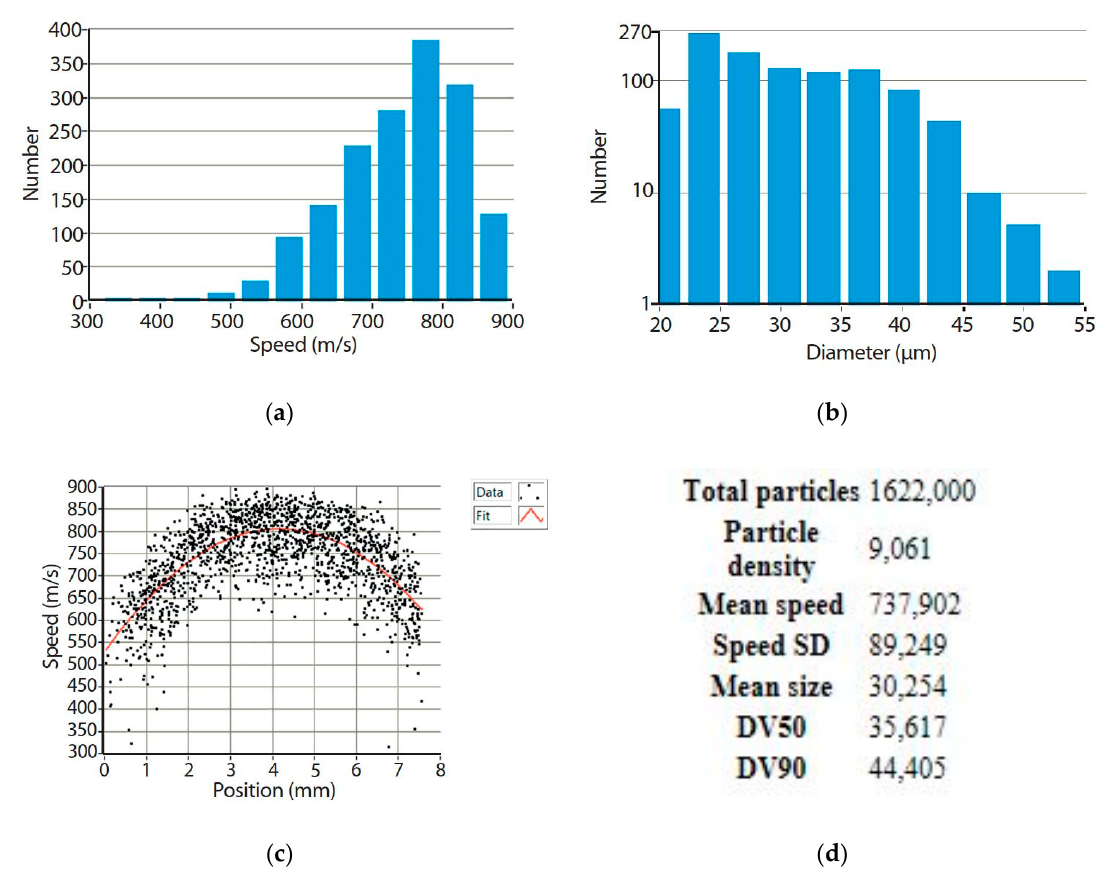
Figure 3. Example of the HW CS2 measurement data: ( a ) particle speed distribution, ( b ) particle size distribution, ( c ) particle speed distribution in x-position with fitting, and ( d ) statistics from the measured data.